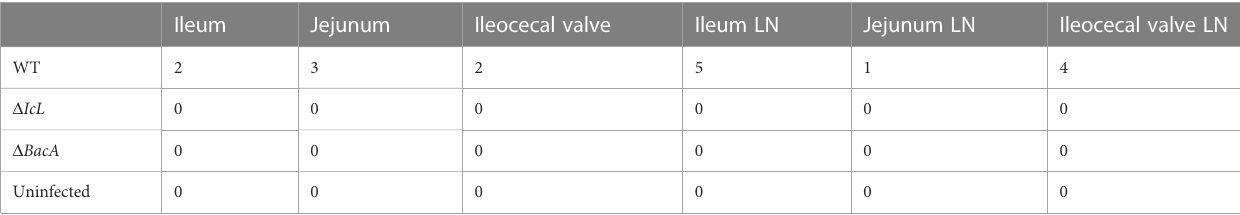
TABLE 2 Number of animals positive for MAP culture.